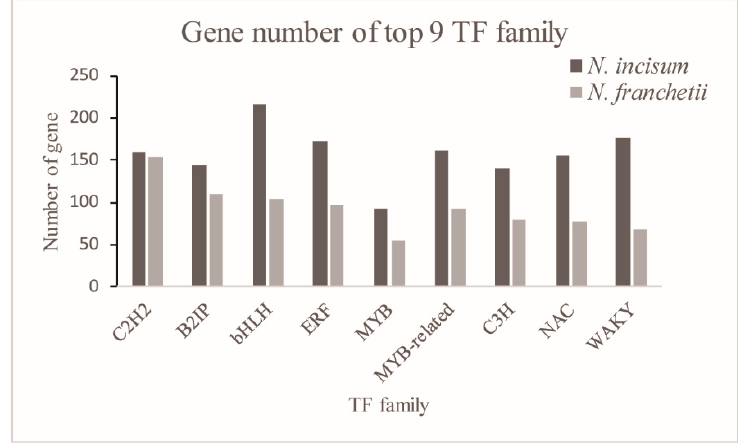
Figure 5. Transcript distribution in various transcription factor (TF) families.